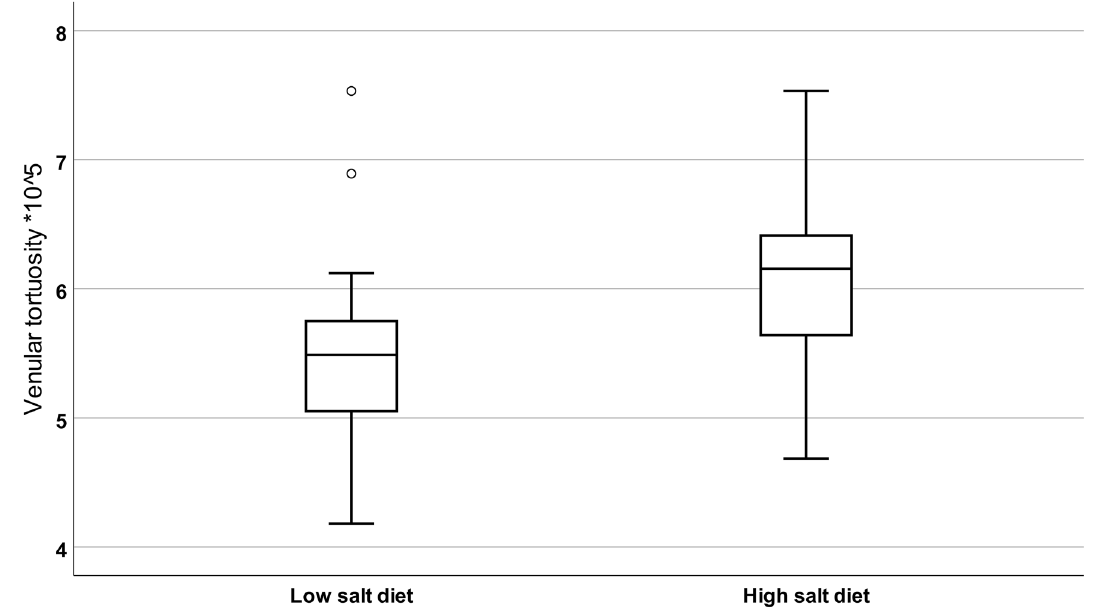
Figure 2. Boxplot of venular tortuosity after low salt diet and high salt diet. Venular tortuosity was significantly higher after the high salt diet (P =